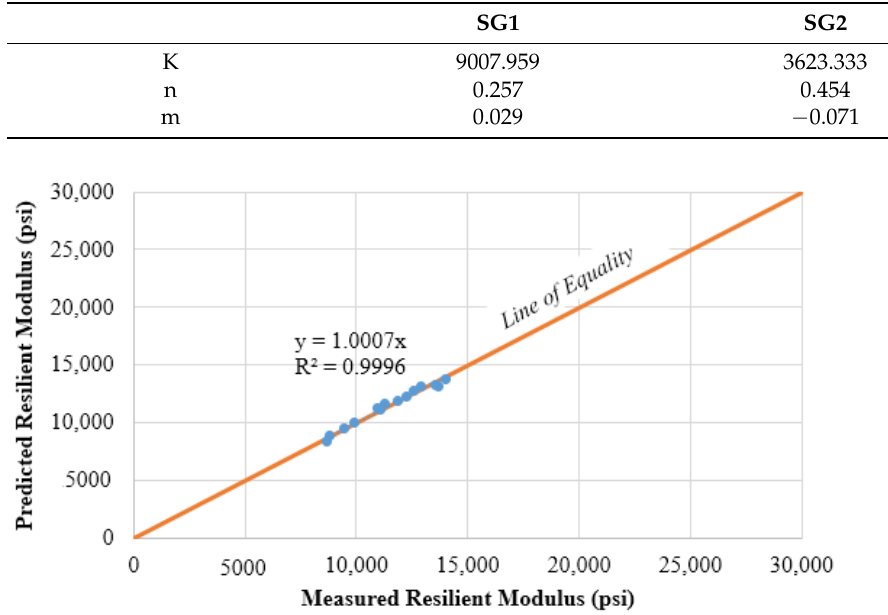
Figure 6. Uzan model for SG2 material.